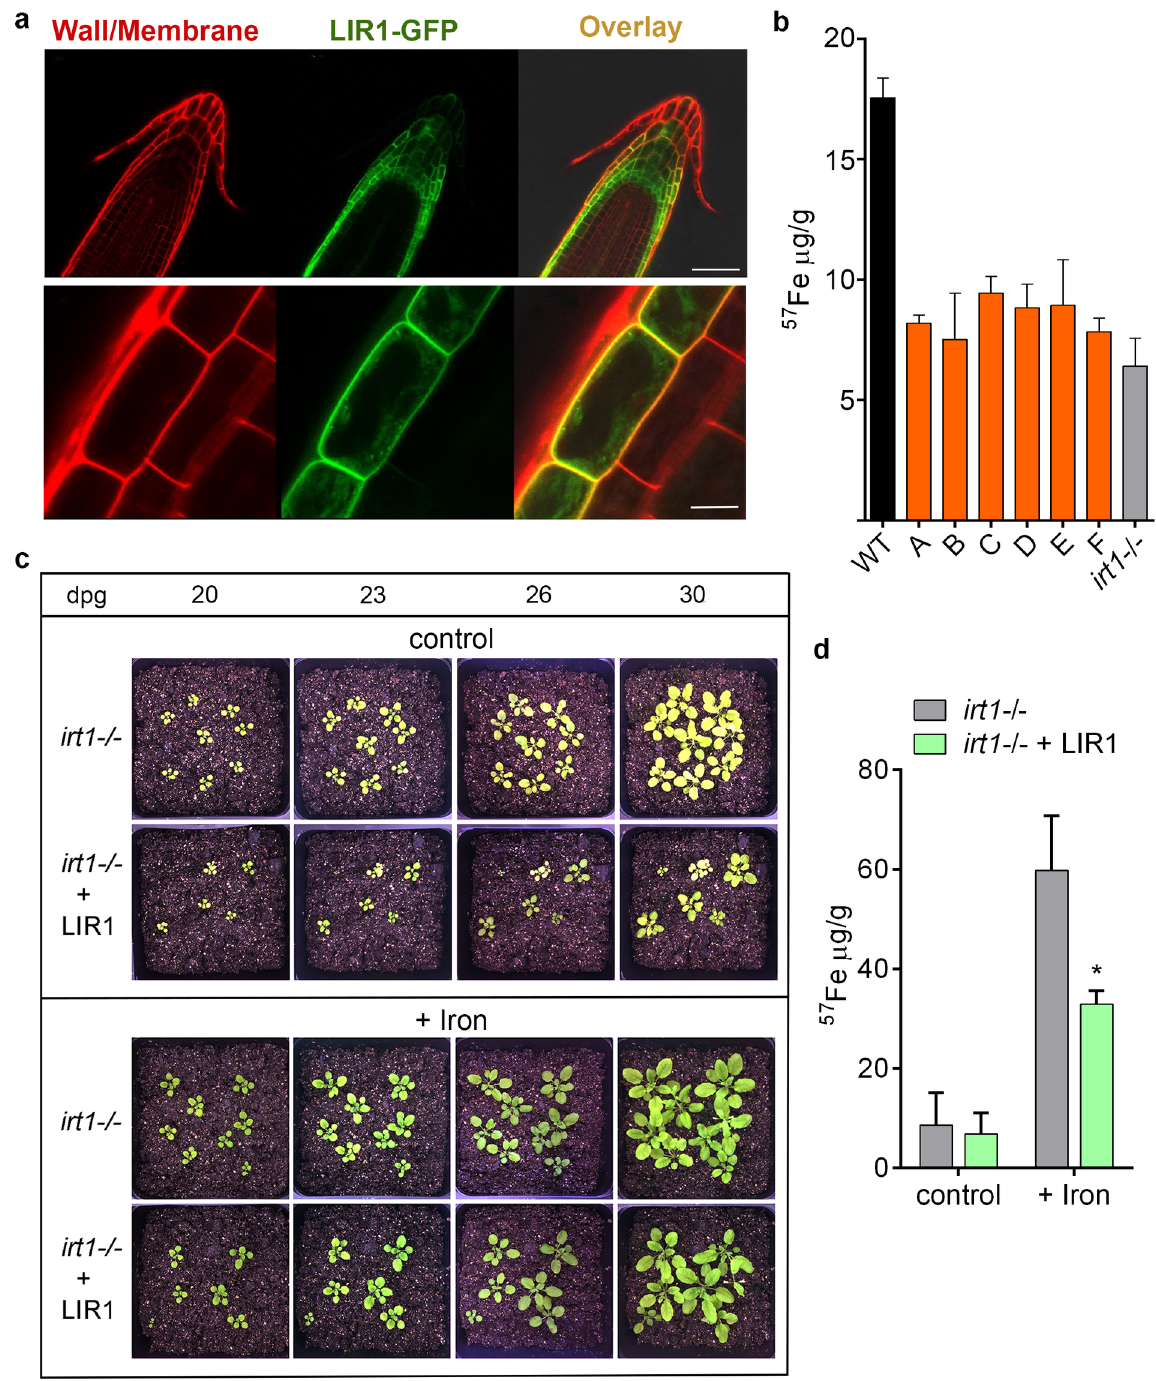
Fig 3. LIR1 expressed in Arabidopsisthaliana is targeted to the plasma membrane and decreases the iron content of leaves. (a) Confocal images of root sections of Arabidopsis thaliana expressing LIR1 fused to GFP at the C-terminus. Red, cell wall/plasma membrane staining with propidium iodide (PI). Green, LIR1-GFP. Scale bars: 50 μm (upper panel) and 10 μm (lower panel). (b) ICP-MS quantification of the iron total content from leaves of wild type (WT), WT expressing LIR1, and irt1-/-Arabidopsis thaliana . A-C, independent Arabidopsis transgenic lines containing the 35S promoter-driven LIR1 cDNA (35S::LIR1). D-F, independent transgenic lines of 35S::LIR1+GFP (35S promoter-driven LIR1 cDNA fused to GFP). The data represent the mean ± SD of 3 samples for each strain, normalized for tissue weight. (c) Phenotype of irt1-/- and irt1-/- expressing LIR1 ( irt1-/- + LIR1) A . thaliana plants grown in soil irrigated with either water (Control) or 0.5 g/L Sequestrene (+ Iron) for 20, 23, 26 and 30 days post germination (dpg). (d) ICP-MS quantification of the iron total content from leaves of irt1-/- and irt1-/- expressing